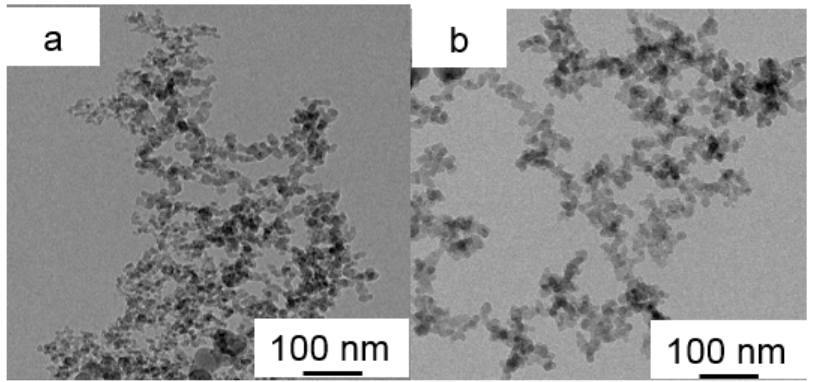
Figure 6. TEM images of SiO 2 aerogel ( a ) and M-SiO 2 aerogel ( b ).